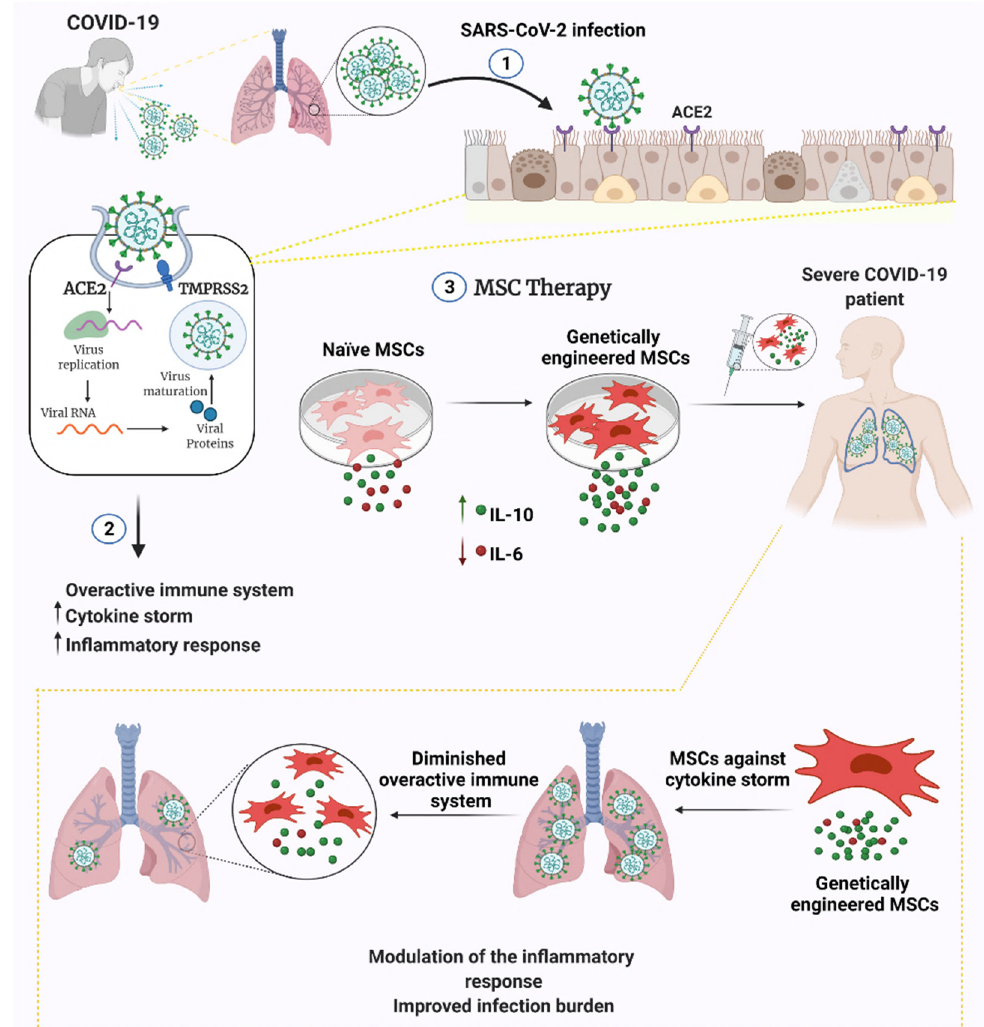
Figure 1. Engineered versus naive MSC therapy against COVID-19. MSCs can be engineered to se- crete anti-inflammatory cytokines and/or genetically silenced for pro-inflammatory cytokine release. Engineering MSCs may be capacitated to prevent infection and prolong MSC longevity/functionality within the patient. Abbreviations: ACE2, angiotensin-converting enzyme 2; TMPRSS2, transmembrane serine protease 2; IL-10, interleukin-10; IL-6, interleukin-6.